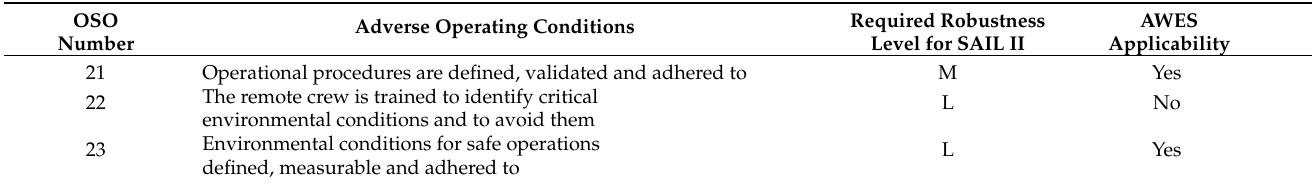
Table 13. Recommended operational safety objectives (OSO) in the SORA and their applicability to commercial AWES, compiled from